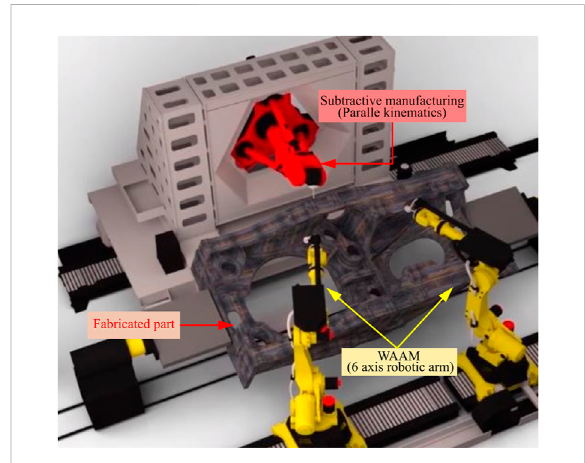
FIGURE 14 Uniform-adaptive hybrid-layering strategy Large Additive Subtractive Integrated Modular Machine.